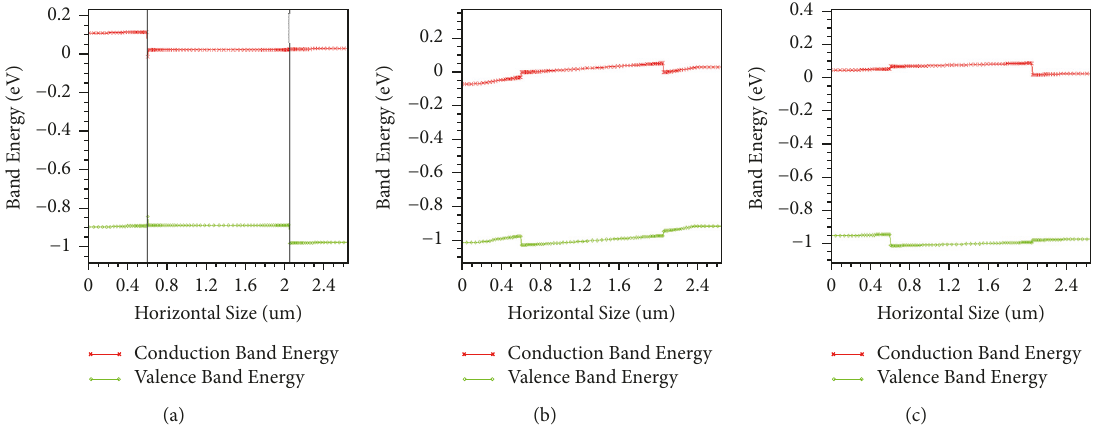
Figure 5: At 1 V forward voltage, the band simulation of three type modulation structures: (a) Si/SiGe/Si-OI structure, (b) SiGe-OI structure, and (c) SOI